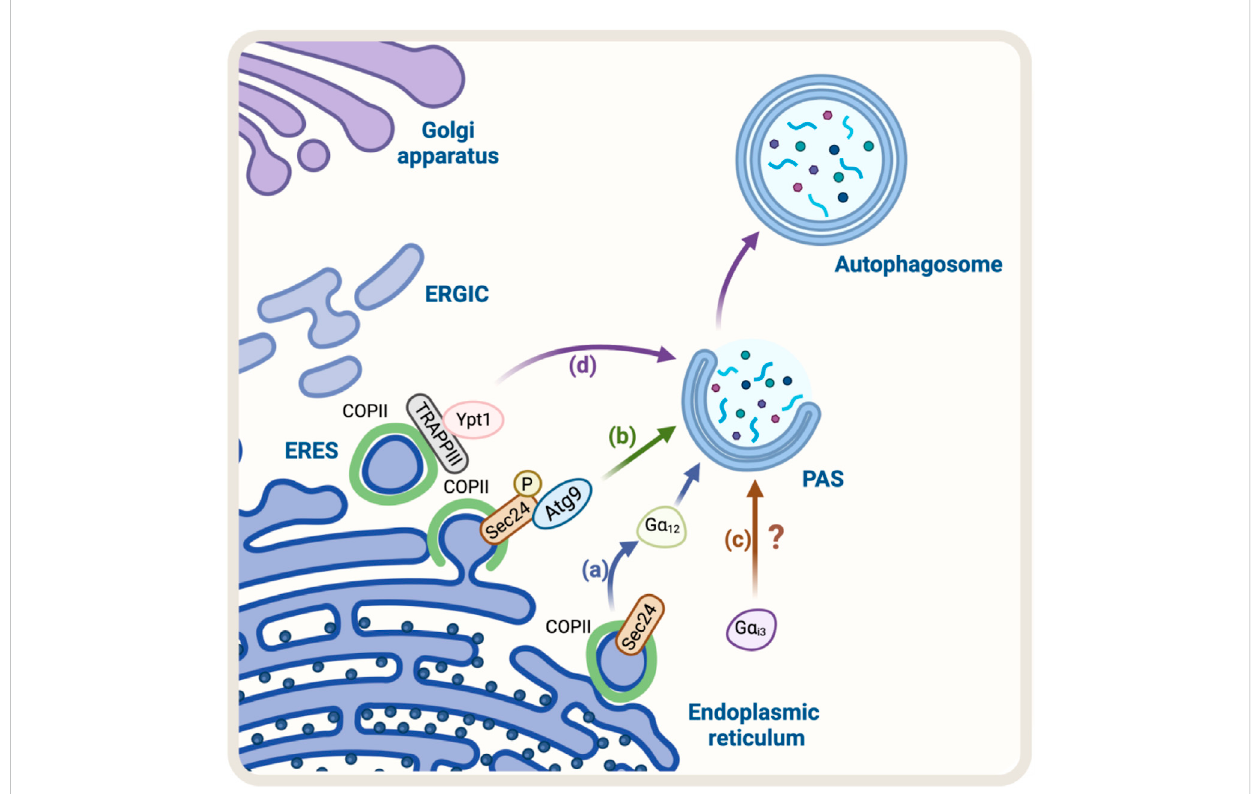
FIGURE 1 Schematic representation of the Regulators of ER-Golgi anterograde pathway and autophagy. (A) SEC24, a COPII protein, acts as a GEF activating thetrimericG α 12 GTPaseto promotecargoexportattheERES.G α 12 activationislinked toautophagosomebiogenesis. (B) Caseinkinase1(Hrr25inyeast) phosphorylates SEC24, promoting its interaction with Atg9 and autophagosome formation (C) G α i3 regulates the initial steps of autophagosome formation. Still, the mechanism remains unknown (D) TRAPPIII, a transport complex that binds to the COPII complex, acts as a GEF for Rab GTPase Ypt1 (the yeast homolog of Rab1 in mammals). Ypt1 modulates PAS